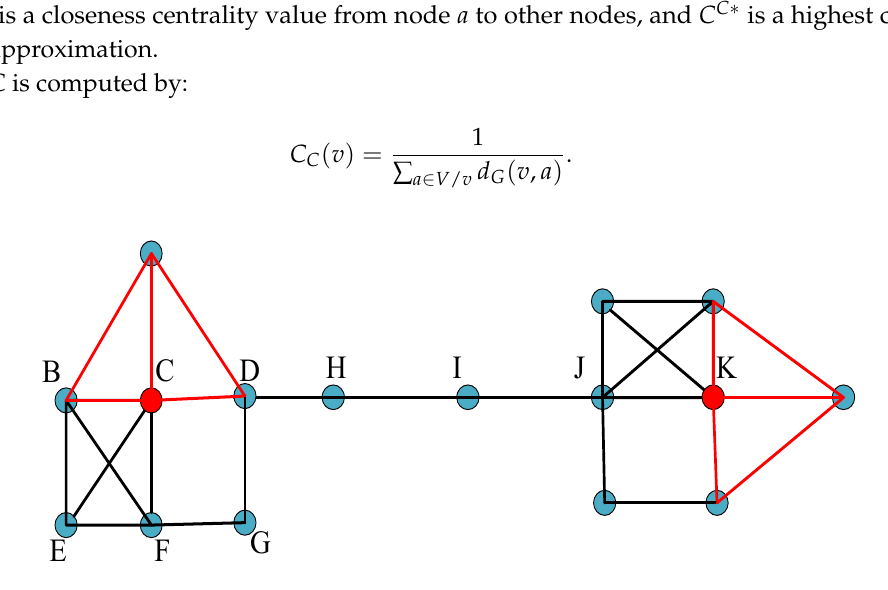
Figure 3. Closeness Centrality in social network analysis